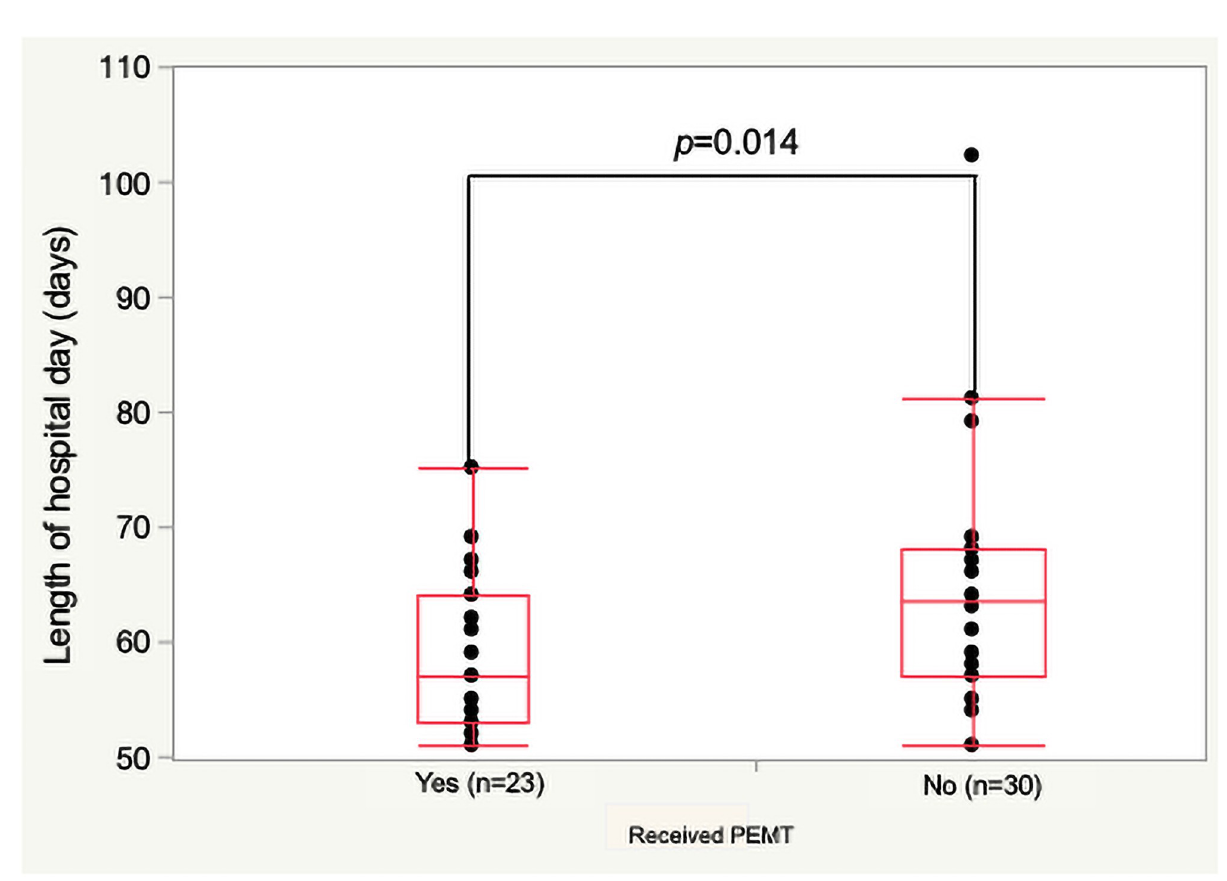
Fig 3. Length of hospital